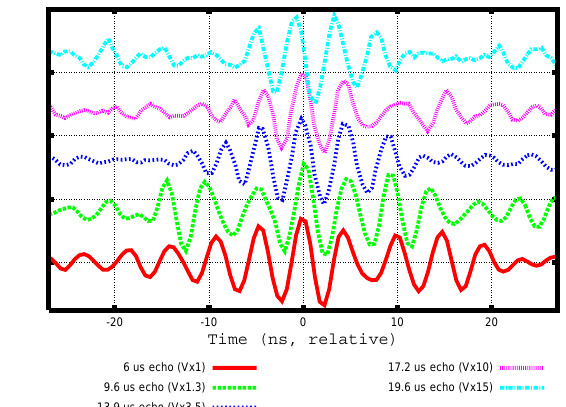
Fig. 9. Power spectrum comparison of direct signal generator output with observed reflection at